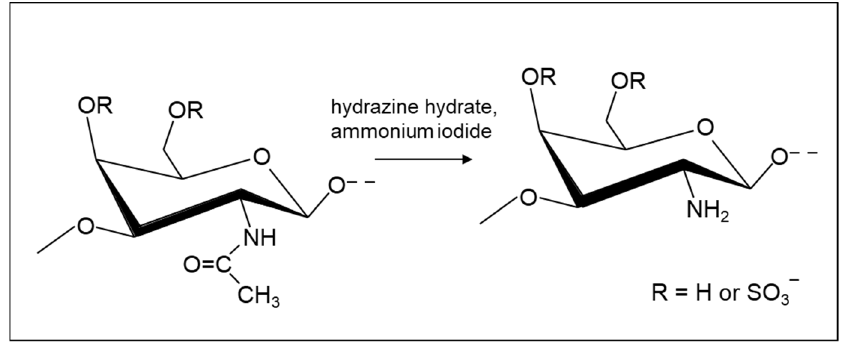
Figure 4. Potential selective de - N - acetylation of β - D - galactosamine in CS or DS achieved using hydrazine hydrate with ammonium salts as catalysts.